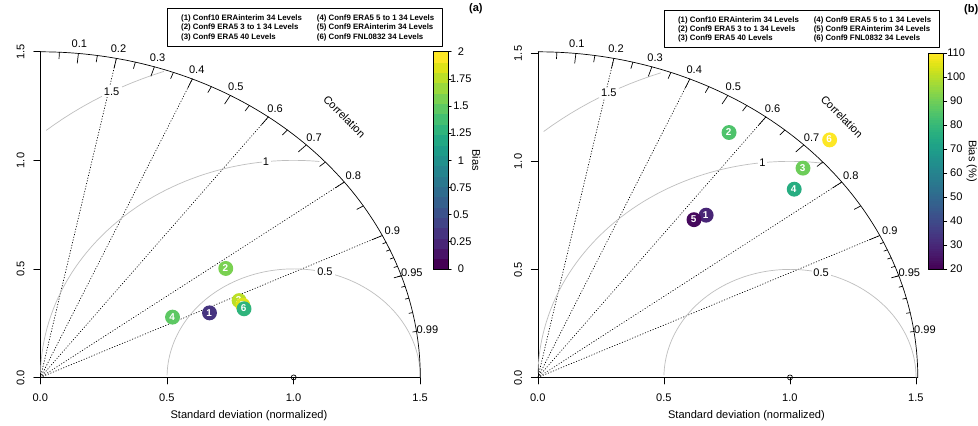
Figure 12. Taylor diagram and bias for different forcing products: ( a ) temperature and ( b )